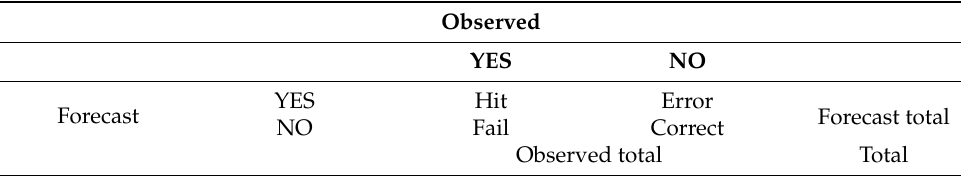
Table 4. Contingency table for binary events (yes/no). Modified from [30]. Observed YES NO YES Hit Error Forecast Forecast total NO Fail Correct Observed total Total